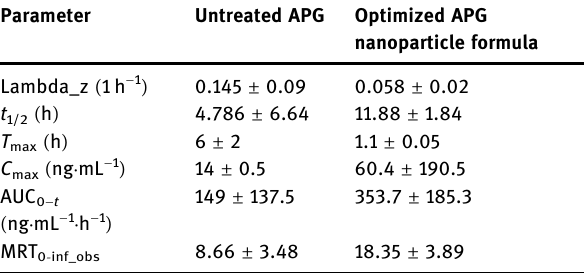
Table 7: Comparison of PK parameters of APG optimized nanopar